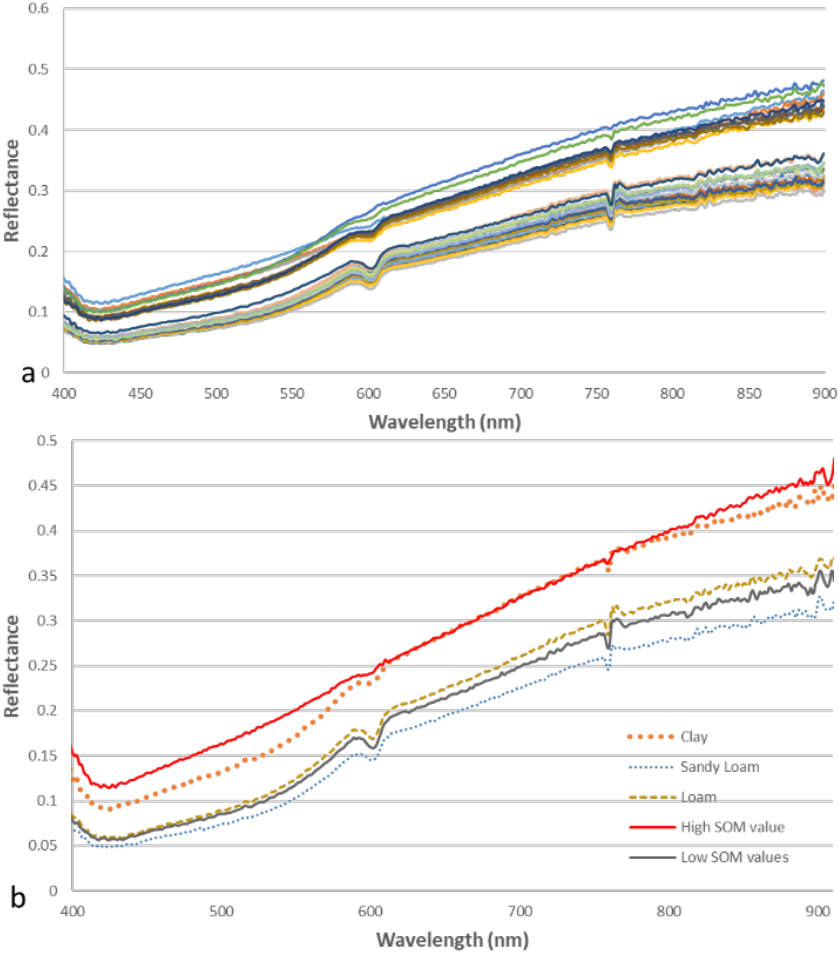
Figure 5. ( a ) Spectral reflectance response of soil samples as derived from spectroradiometer. ( b ) Soil sample soil organic matter (SOM) values and texture analysis in terms of spectral reflectance (mean values) .